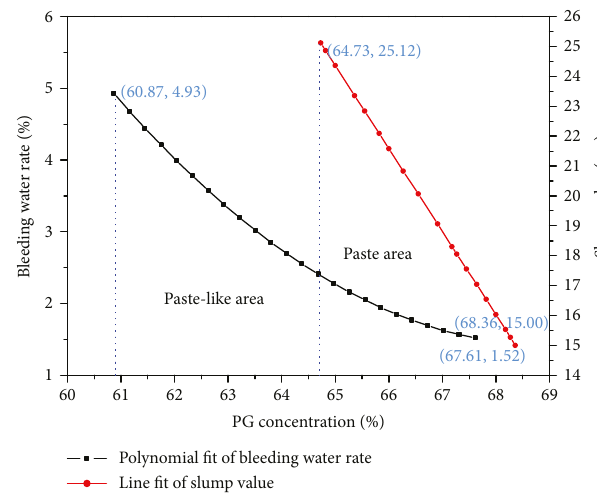
Figure 15: Measured pressure values of gauges 1 and 2 in industrial test.